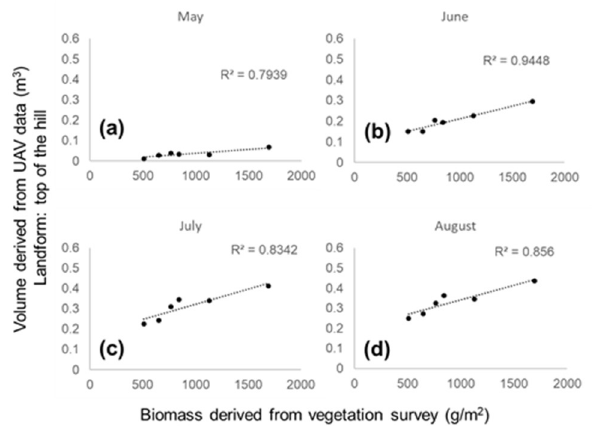
Figure 11. Comparison between volume of M. sinensis